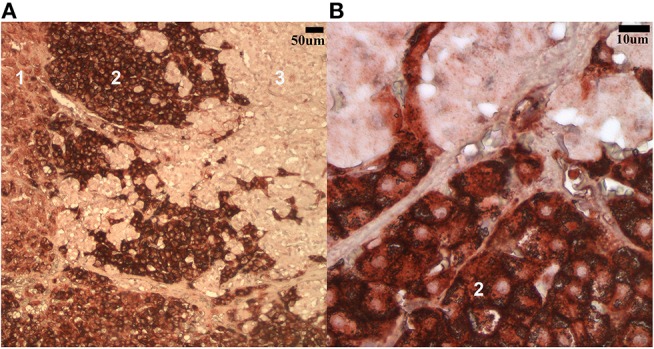
Low (A) and high (B) magnification (100x and 500x, respectively) images of the steroidogenic cells in the canine adrenal gland labeled with the SR-B1 antibody. The most intense staining is noted in the fasciculata layer (2) while less intense positive staining is seen in the zona glomerulosa (1) and zona reticularis (3).